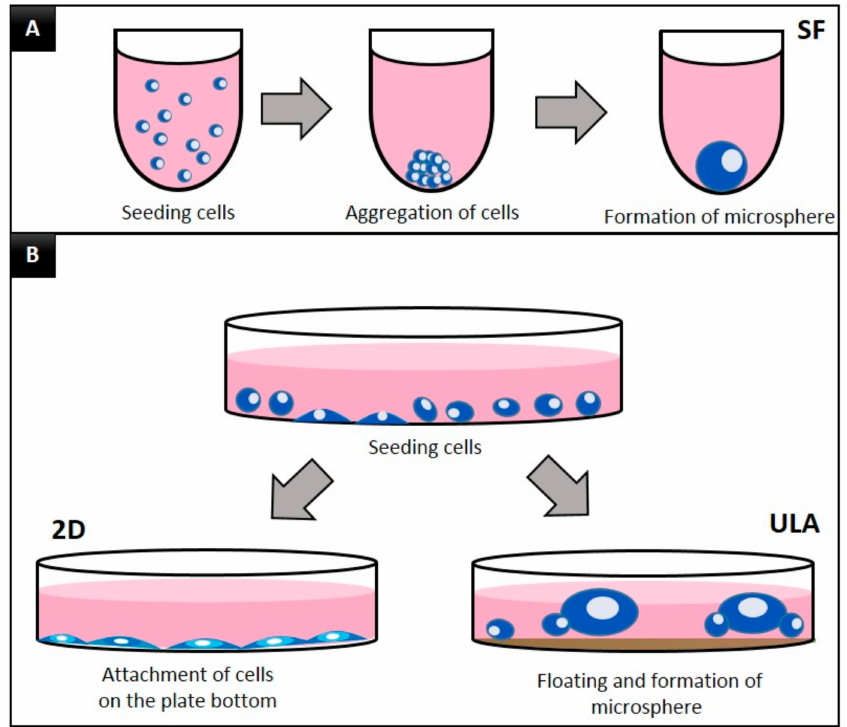
Figure 1. Schematic diagram of the experimental groups. ( A ) SF group: U-bottomed StemFit 3D (SF) plates, ( B ) two-dimensional (2D) group, conventional flat-bottom cell culture plate, ULA group: ultra-low attachment